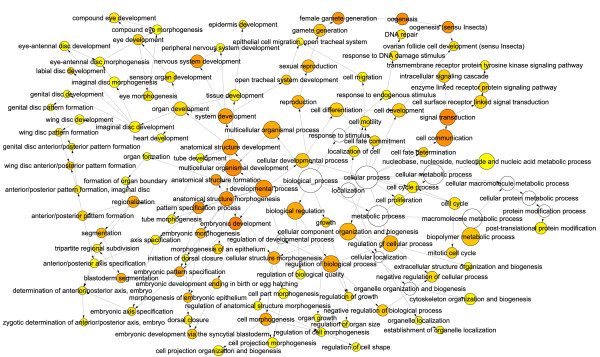
sticky BiNGO. Directed acyclic graph of over-represented GO-terms in the highest scoring sticky active sub-network. Node size indicates the number of genes associated with each GO-term (i.e. larger nodes represent GO-terms associated with many genes in the active sub-network). Node color indicates significance of over-representation based on Benjamini-Hochberg corrected p-value: white = p > .0001, yellow = p < .0001, red = p << .0001.